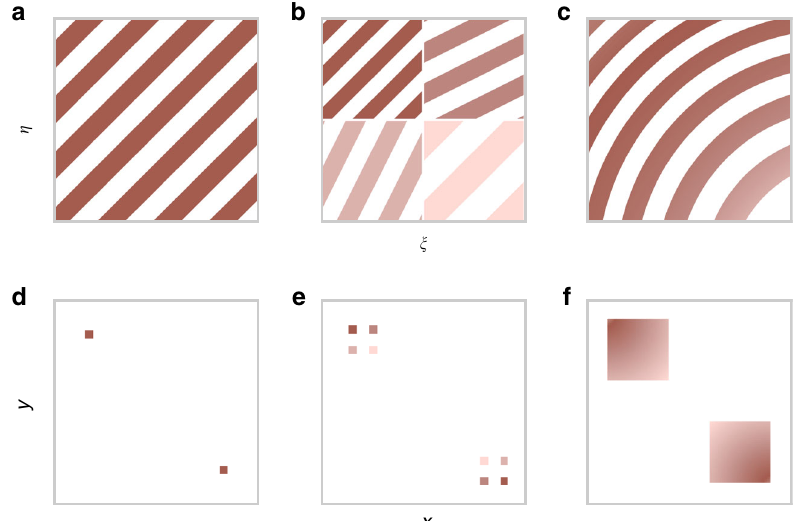
Fig. 3 Schematic evolution of our grating design from regular gratings. The images show the real-space structures a – c and respective diffraction pattern d – f . a A regular grating diffracts incoming light to two symmetric points in Fourier-space d and hence reveals no spatial information on the illumination function. b A two-by-two segmented grating yields two symmetric sets of four diffraction spots e . The intensity of each spot is proportional to the illumination of the corresponding sample quadrant. This constitutes the most basic form of a spatially resolving beam pro fi le monitor based on an integrated grating. c A grating with suitably varying period and orientation forms a magni fi ed image of its own illumination in Fourier-space f . The colors in the real-space images indicate the local grating period and mark the corresponding points in the diffraction